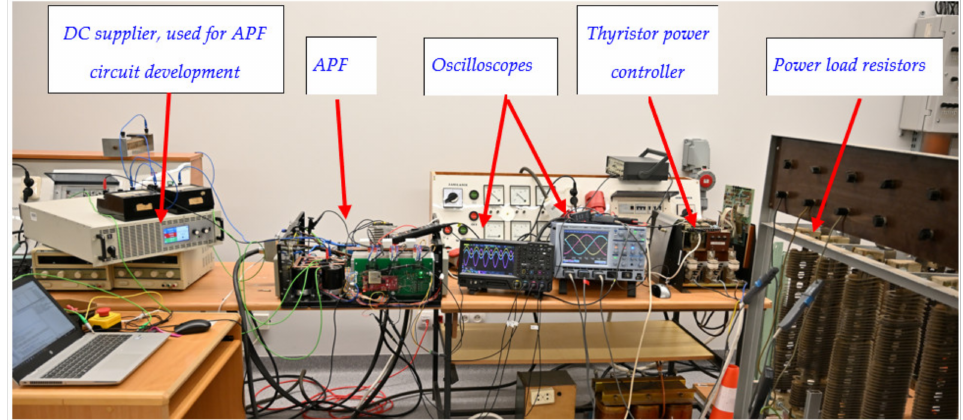
Figure 11. A view of the APF laboratory